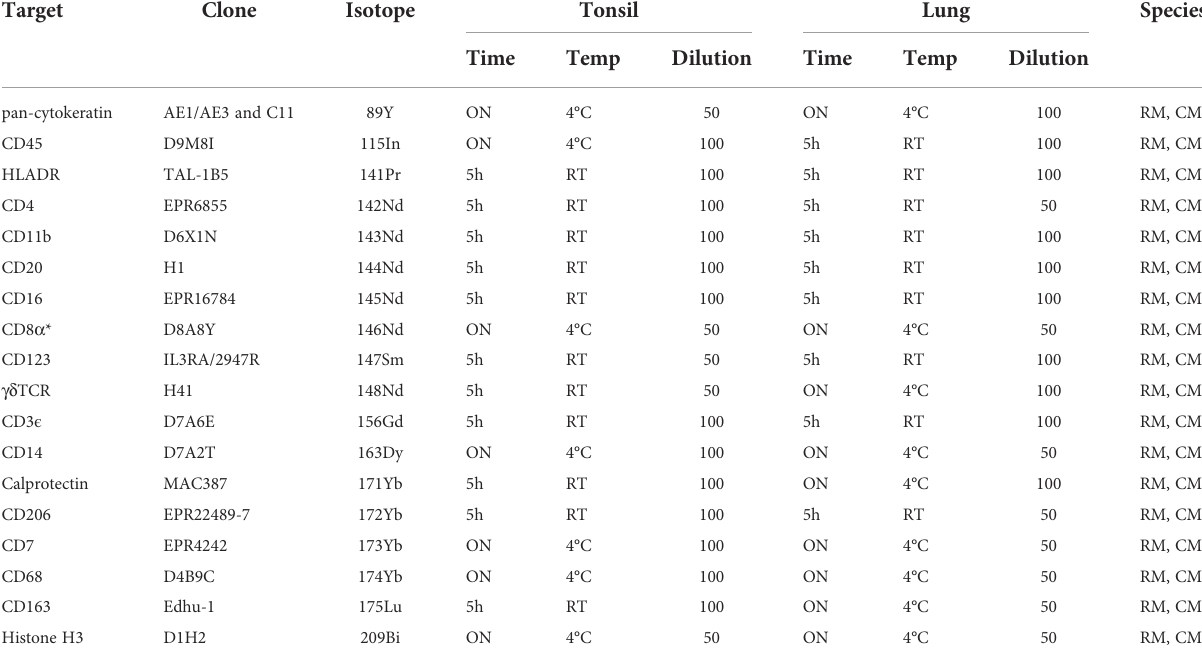
TABLE 1 18-marker panel for imaging mass cytometry, with antibody-metal combination, antibody clone and staining conditions for tonsil and lung tissue.